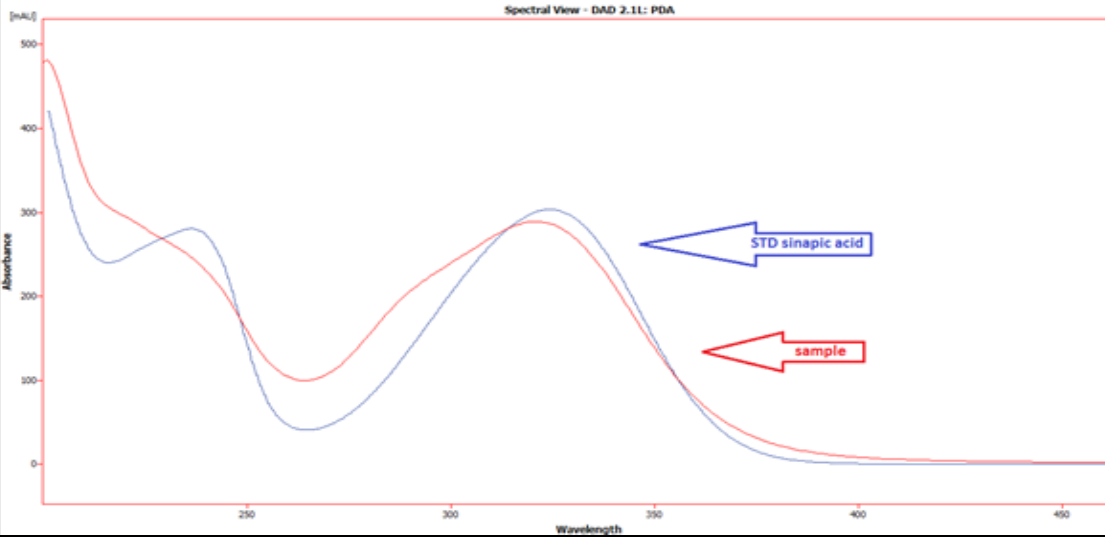
Figure 17. The UV spectrum of isolated compound number 2 and Sinapic acide standard